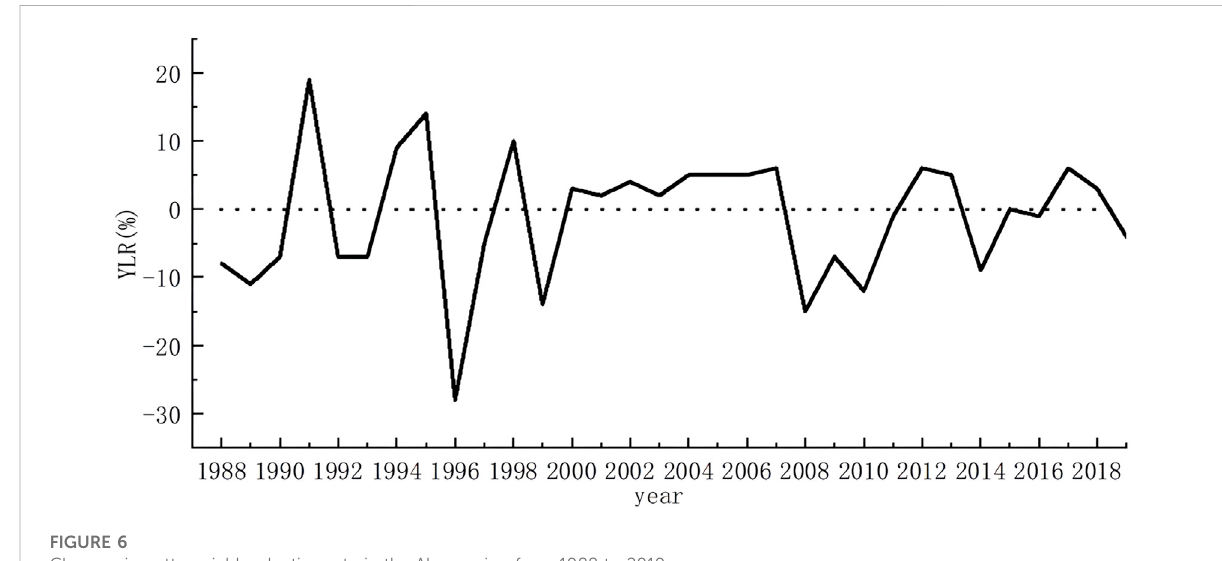
FIGURE 6 Changes in cotton yield reduction rate in the Aksu region from 1988 to 2019.